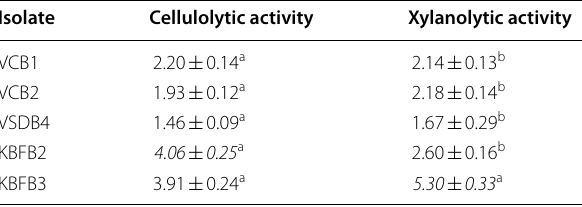
Values represent mean ( same alphabets are not significant from each other as determined by DMRT at p 0.05 = Maximum values are in italic